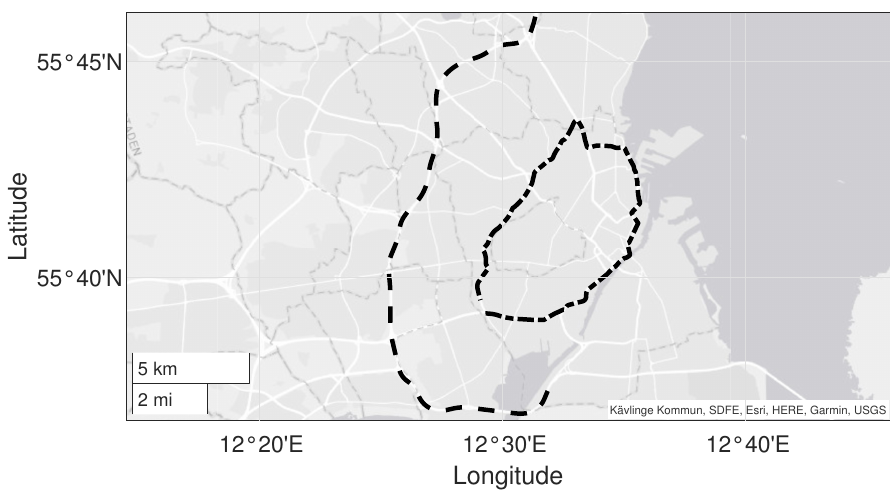
Figure 4. Overview of roads utilized in the experimental investigation: map of highway road M3 (marked with a black dashed line) and urban city ring O2 (marked with black dashed-dotted line) in the proximity of Copenhagen city, Denmark.